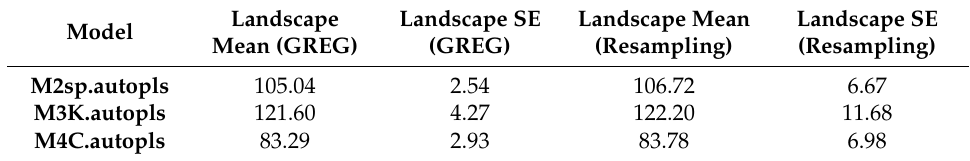
Table 6. Mean AGB per hectare (t · ha − 1 ) and standard error (SE) on a landscape scale using either a generalized regression estimator or a resampling technique. The resampling technique repeatedly fits the model to a stratified subsample of 17 plots only. (Standard general regression estimator (GREG)). Landscape Landscape SE Landscape Mean Landscape SE Model Mean (GREG) (GREG)